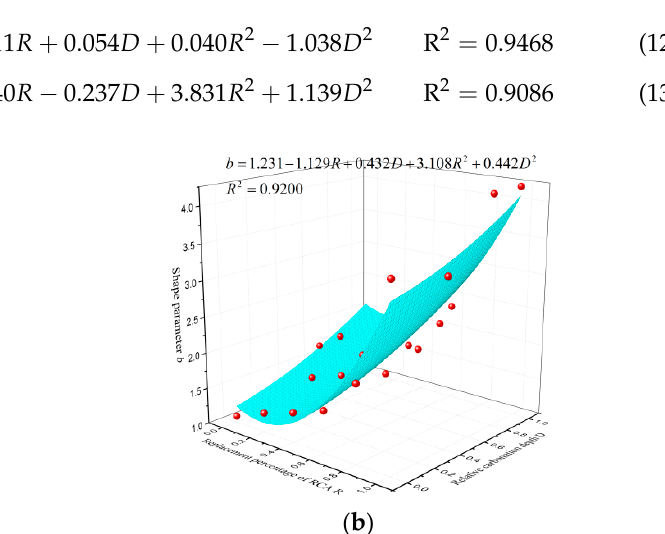
Figure 12. Three-dimensional fitting of shape parameters: ( a ) shape parameter a , ( b ) shape parameter b.